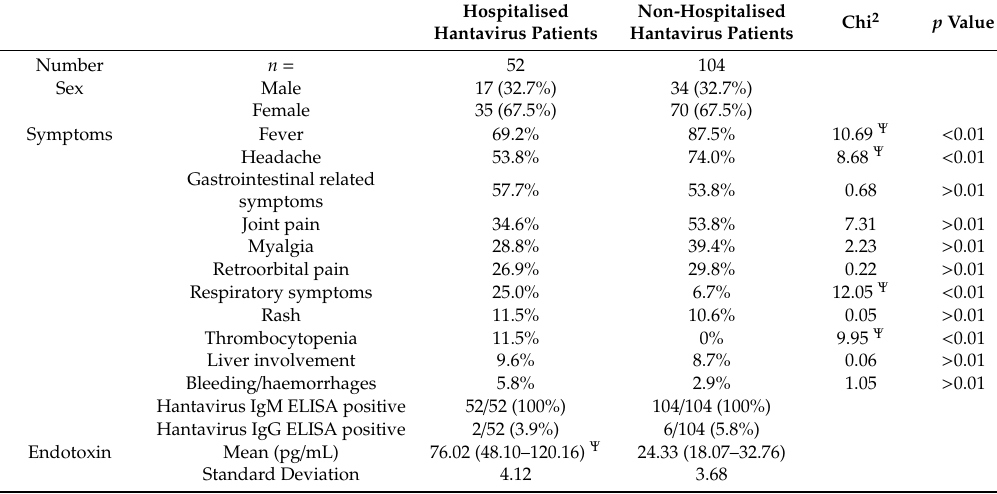
Table 2. Comparison of hospitalised hantavirus patients vs. non-hospitalised hantavirus year, age- and sex-matched patients by sample size, sex, serum endotoxin levels, hantavirus ELISA results and clinical symptoms (2008–2015).